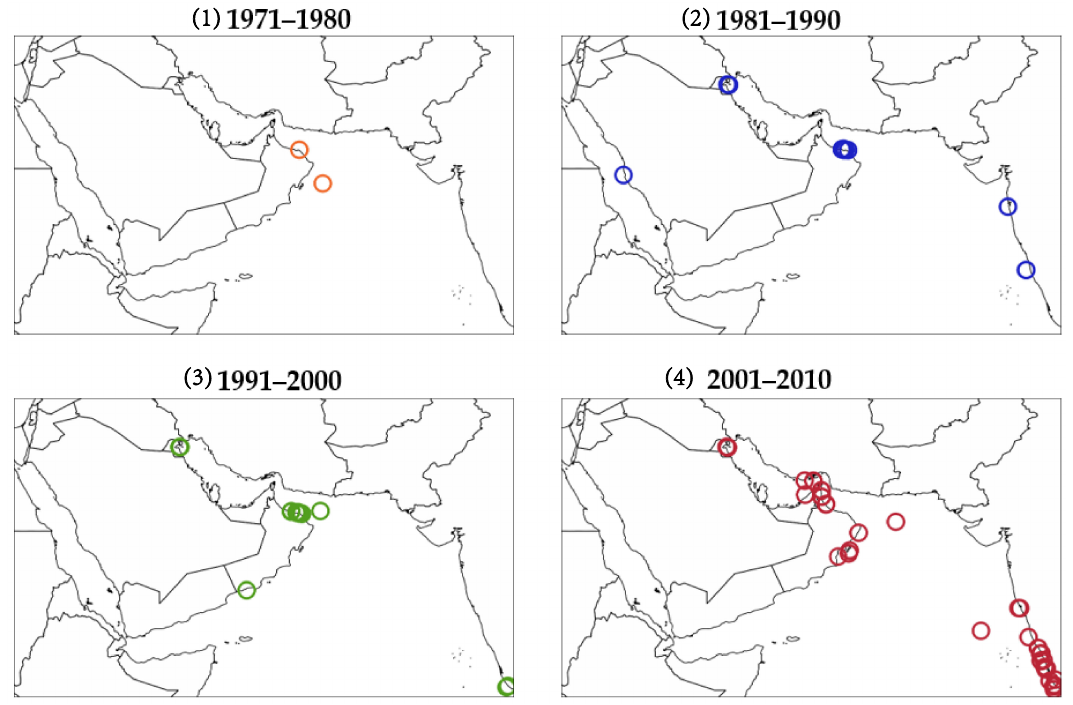
Figure A1. Algal bloom outbreaks in the NIO during September–November over four decades: